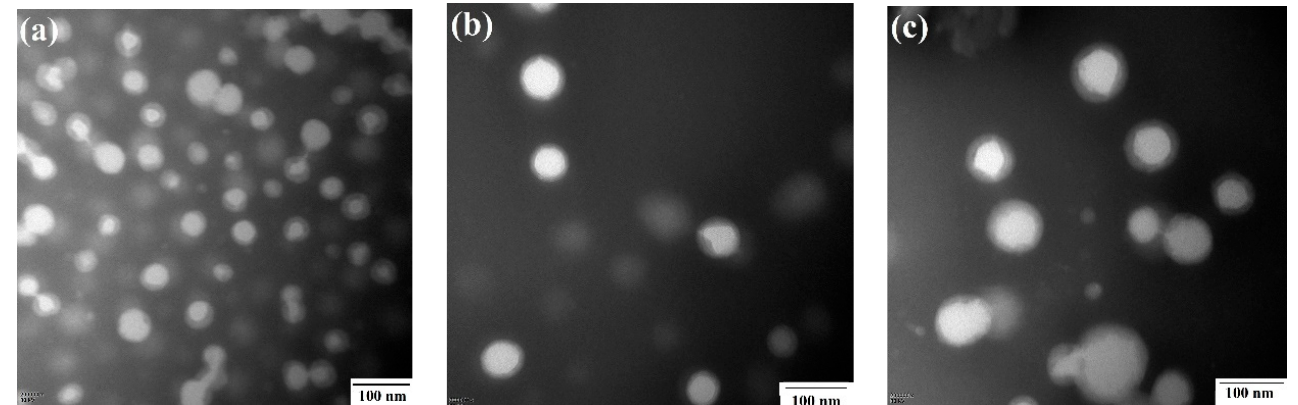
Figure 5. TEM of the TPFPUs: ( a ) TPFPU-1, ( b ) TPFPU-4 and ( c ) TPFPU-7.